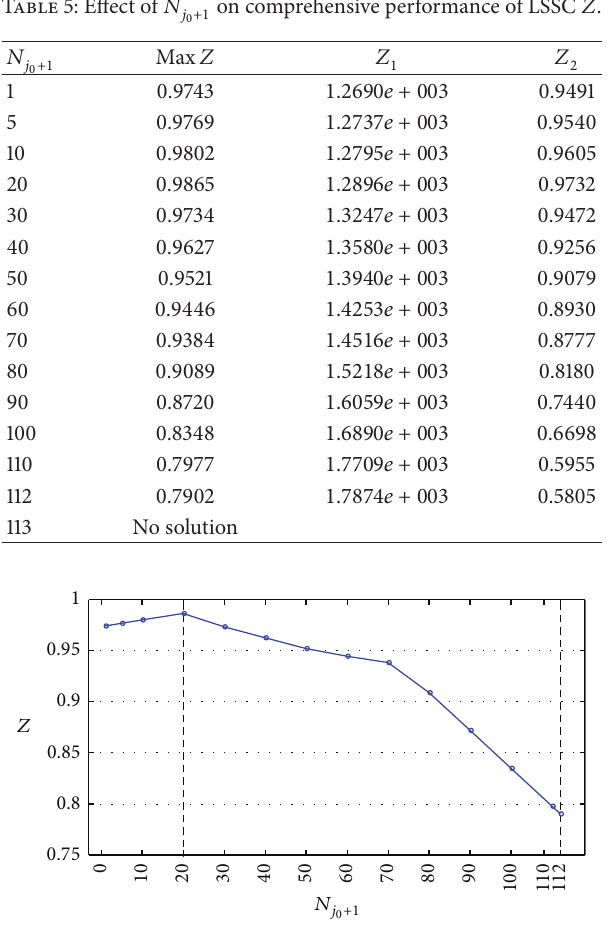
Figure 5: Curve of 𝑍 varied with 𝑁 𝑗